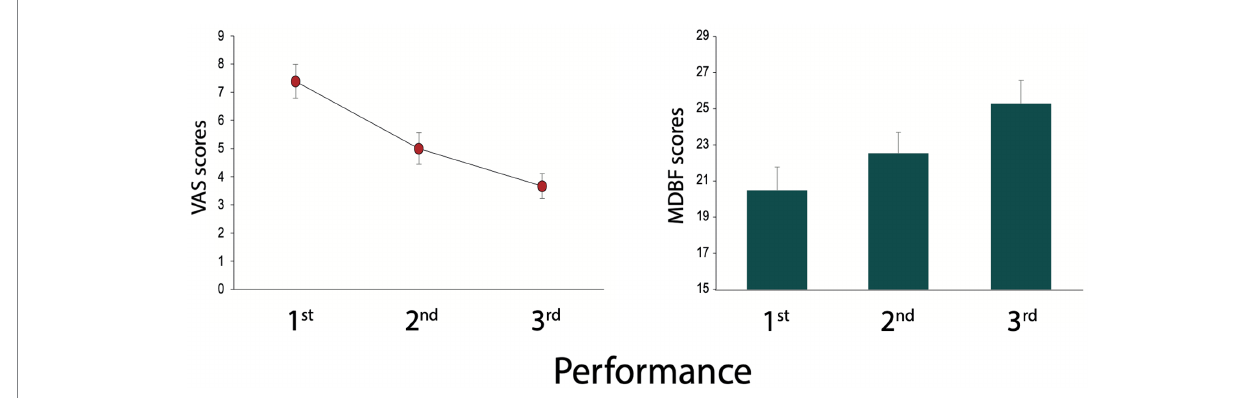
FIGURE 2 MPA-Questionnaire and MDBF-Questionnaire MDBF (RU scale). Tailored MPA questionnaire ( left ; VAS: 10 = MPA at maximum). MDBF (RU scale; right ), which indicates the degree of rest-restlessness. Higher values mean more calmness and serenity. Shown are mean values and S.E. of the